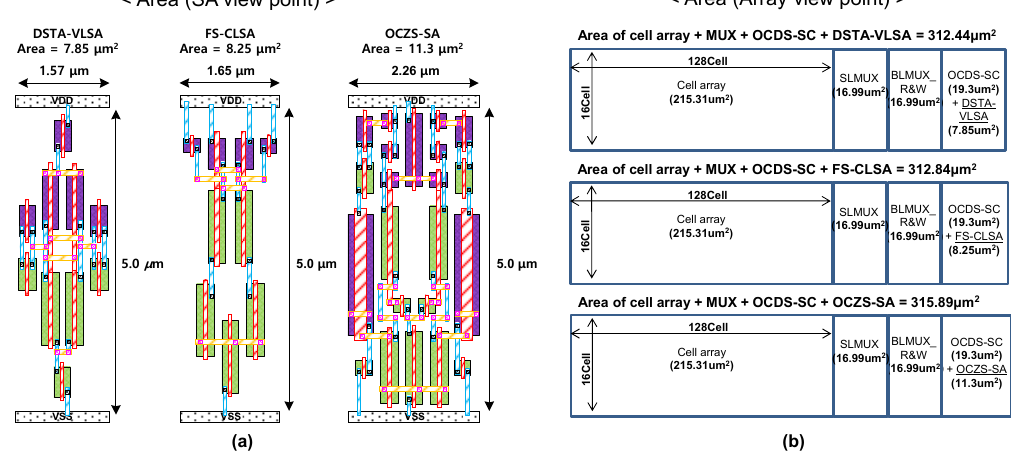
Figure 11. ( a ) Simplified layouts of DSTA-VLSA, FS-CLSA, and OCZS-SA. ( b ) Estimated array architecture areas when DSTA-VLSA, FS-CLSA, and OCZS-SA are employed.